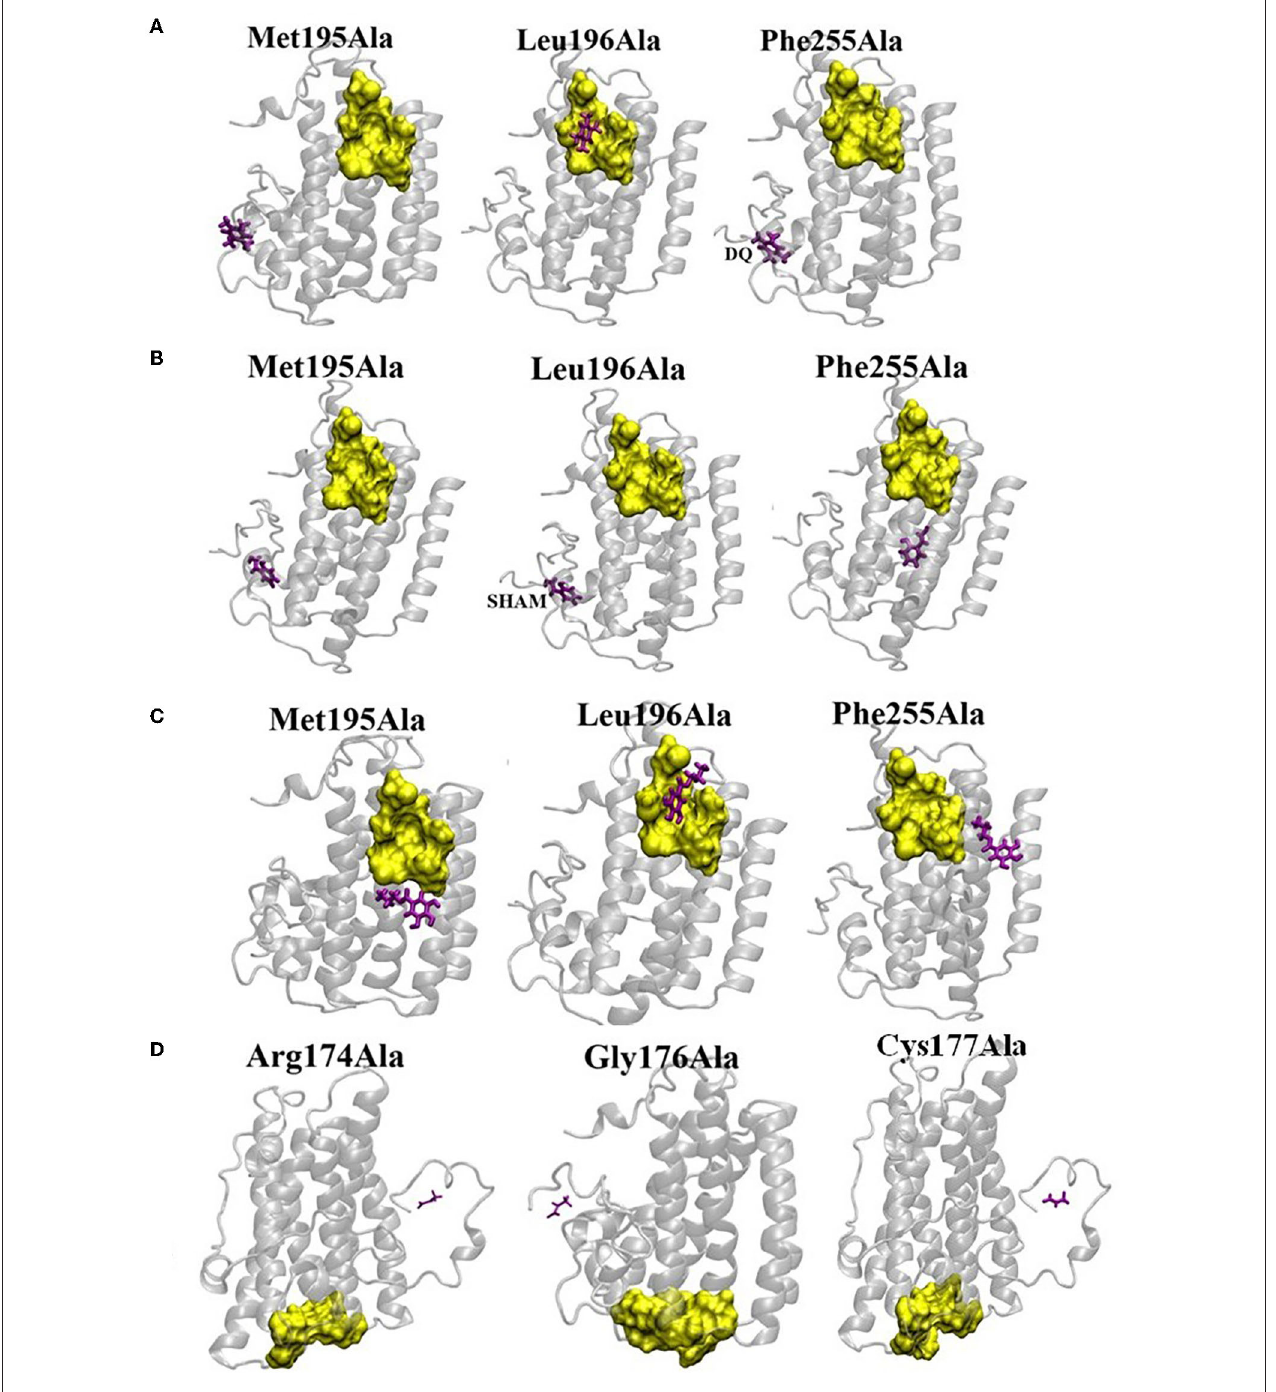
FIGURE 7 | Effect of mutation on the binding affinities of DQ (A) , SHAM (B) , n-PG (C) , and Pyruvate (D) . The yellow surface indicates the location of the binding pocket in wild type (WT) AtAOX1A. The location of the ligand on the mutant AtAOX1A is shown in purple.